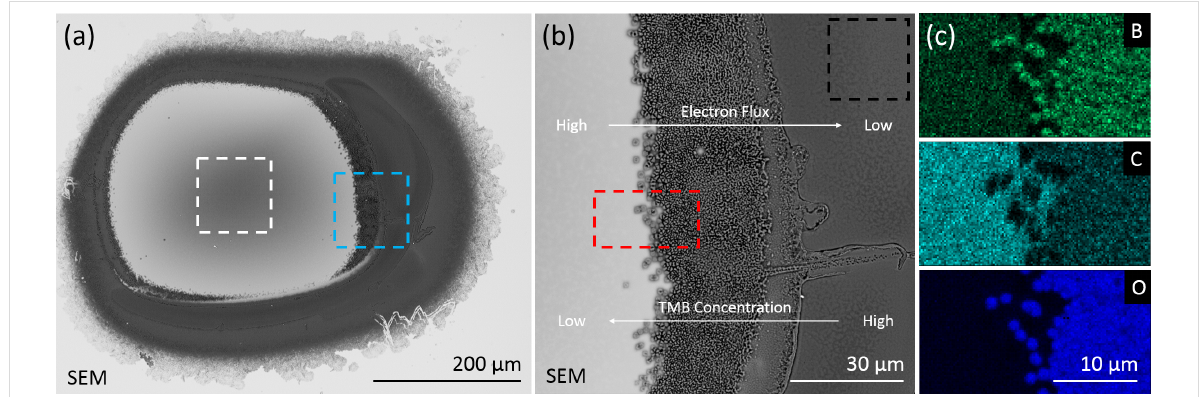
Figure 4: Backscattered scanning electron image of (a) the entire region and (b) the edge region (ca. 100 μ m from the center of the electron beam, indicated by the blue box in (a)) of a deposit performed at a substrate temperature of 271 °C. At this temperature, diffusion-limited replenishment of TMB precursor results in an abrupt inner edge in the deposition profile. (c) Elemental maps of boron, carbon and oxygen at the TMB precursor deple- tion boundary measured by EDS (the region is indicated by the red box in (b)). Regions noted in Figure 3 as center, diffusion and edge are indicated by the white, red and black boxes,